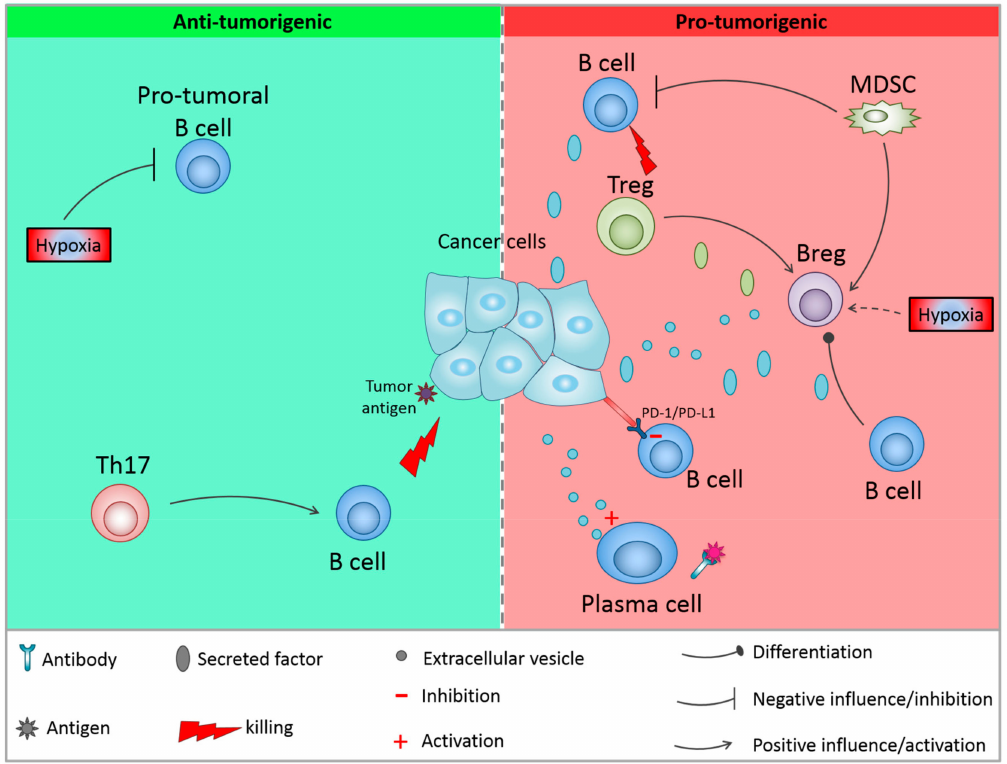
Figure 2. Influence of the microenvironment on B cells functions. Anti-tumor activities can be reinforced by di ff erent factors such as hypoxia or IL-17 production by T cells. On the other hand, other immune cells from the microenvironment can activate Bregs and kill anti-tumor B cells. In addition, the tumor cells themselves can influence B cells activity. CTL = cytotoxic T cells; Th17 = IL-17 producing T helper cell; MDSC = myeloid derived suppressive